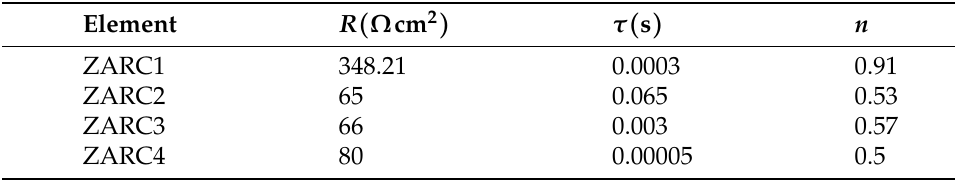
Figure 14. Cole–Cole fitted circuit. Table 7. ZARC values for the elements in circuit from Figure